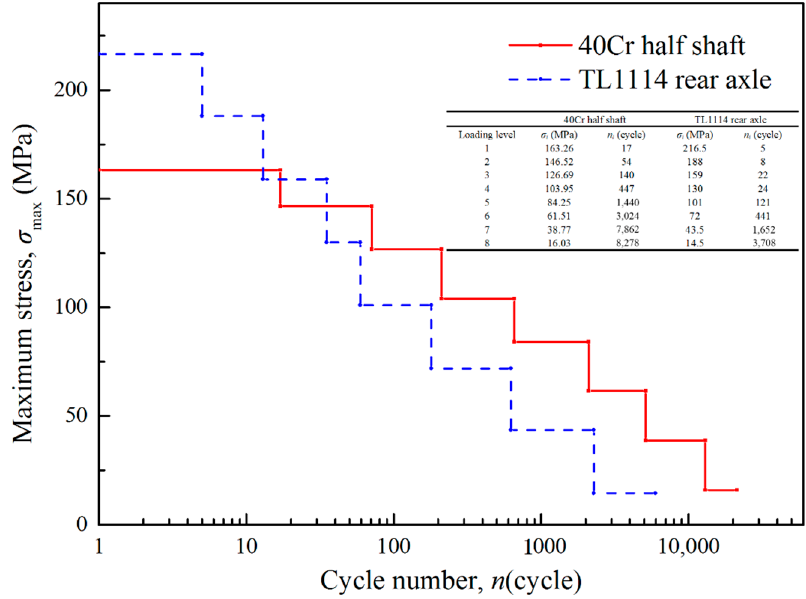
Figure 6. The loading histories of the 40Cr half shaft and the TL1114 rear axle. Table 3. Comparisons on fatigue lives between damage models and test.